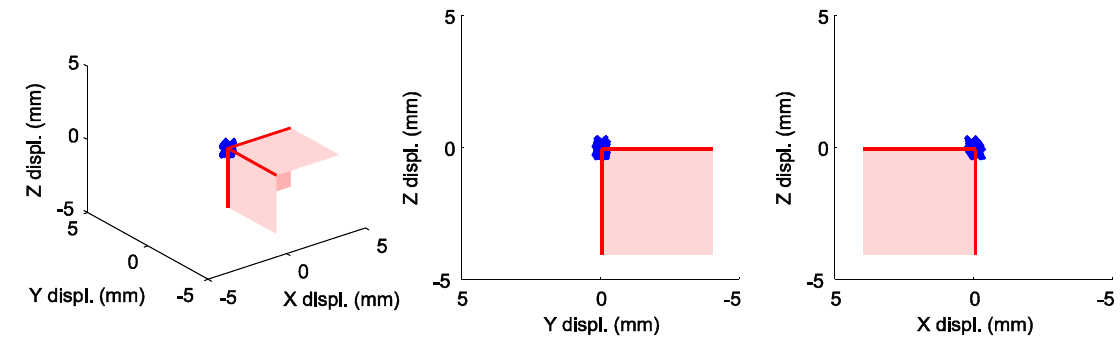
Figure 10. The calibrated positions of the WOCS origins are marked with blue crosses, while the assumed correct position of the UU WEC stator section corner is shown in